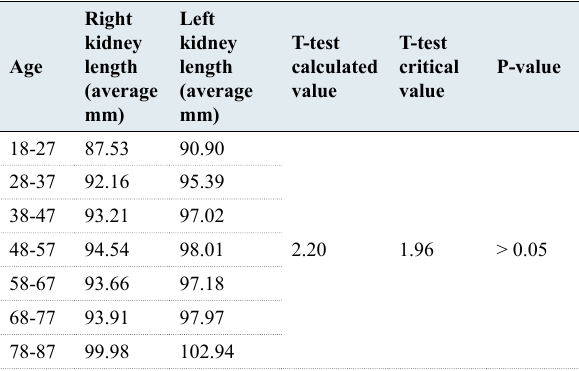
Table 2: T-test table on the consociation between